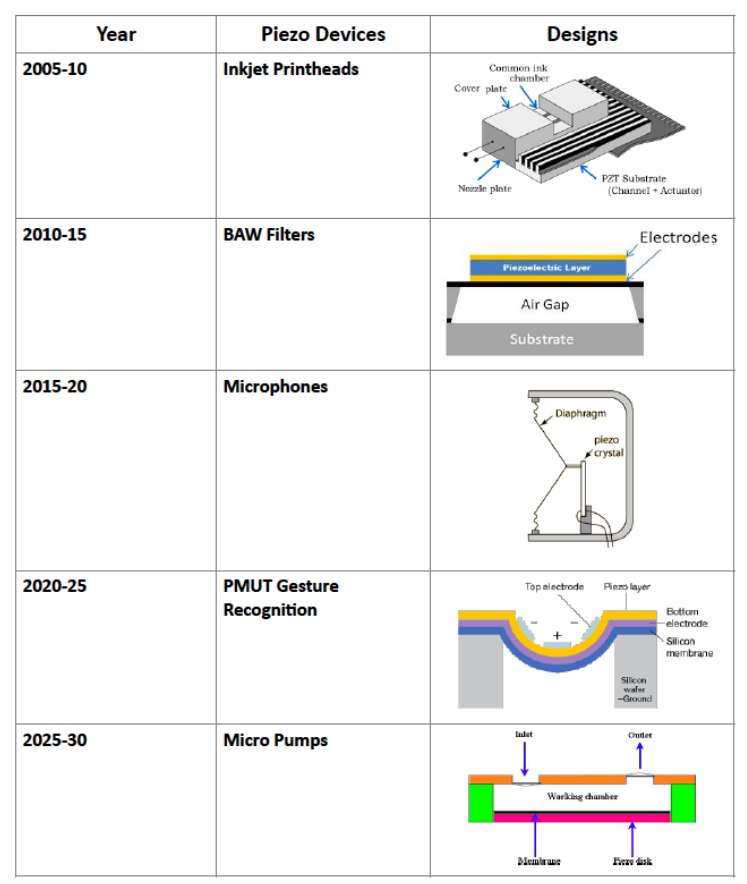
Figure 5. Advancement in piezoelectric energy harvesting for